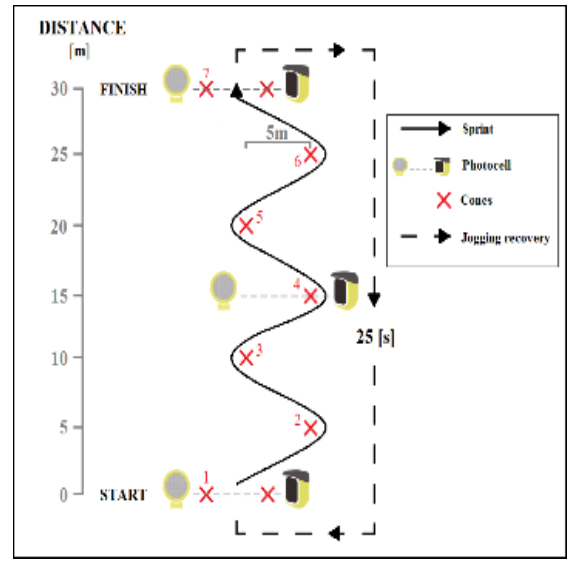
Figure 3. The repeated sprint test involving changes in direction .